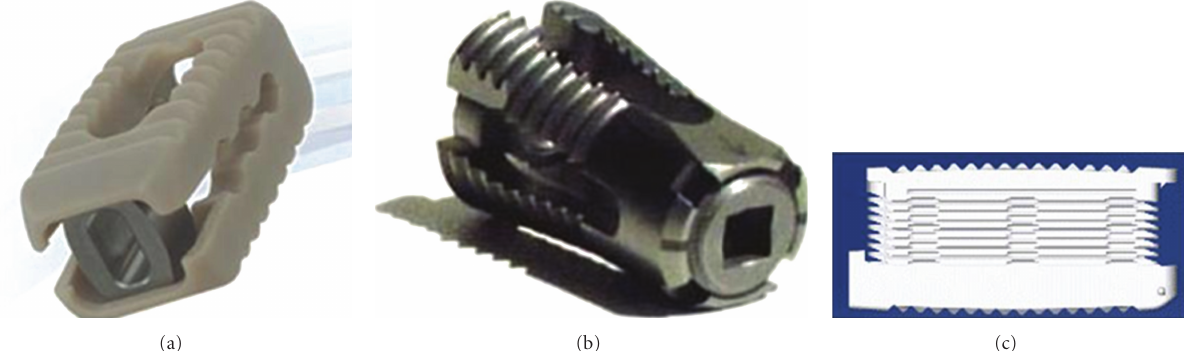
Figure 3: Expandable interbody cages. (a) Varian (Medyssey spine, Skokie, IL, USA), (b) VariLift-L (Wenzel spine, Austin, TX, USA), and (c) StaXx XDL (Spine wave, Shelton, CT, USA)